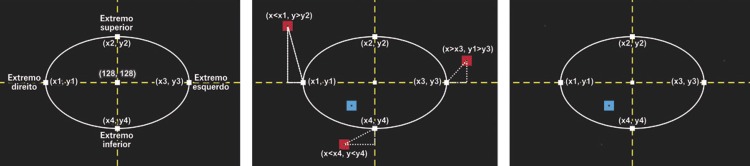
Segmentação por meio do método de detecção por coordenada. À esquerda, é feita a demarcação dos pontos extremos do cérebro. No segundo quadro, é ilustrada a localização das subregiões externas e internas do cérebro. Por último, eliminam-se todas as subregiões externas ao cérebro